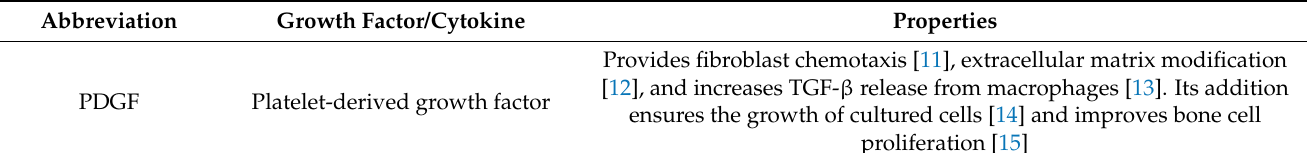
Table 2. Description of growth factors and cytokines within the